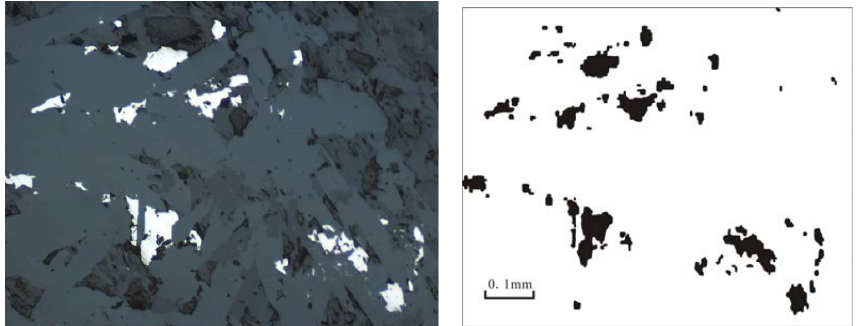
Fig.1. ( a ) The digital image of the sample from the second basalt segment under the Environmental Scanning Electron Microscope (ESEM). ( b )Rock binary image, the pyrrhotite particle with black pixels and the gangue mineral in white. This figure only extracts the major pyrrhotite particles from the ESEM image in Fig. 1a in order to eliminate the distortion by the magnification scale. And used for calculation in the paper are the pyrrhotite particles shown as the black pixels. Table 1. Basic information about the samples used for analysis. Basalt